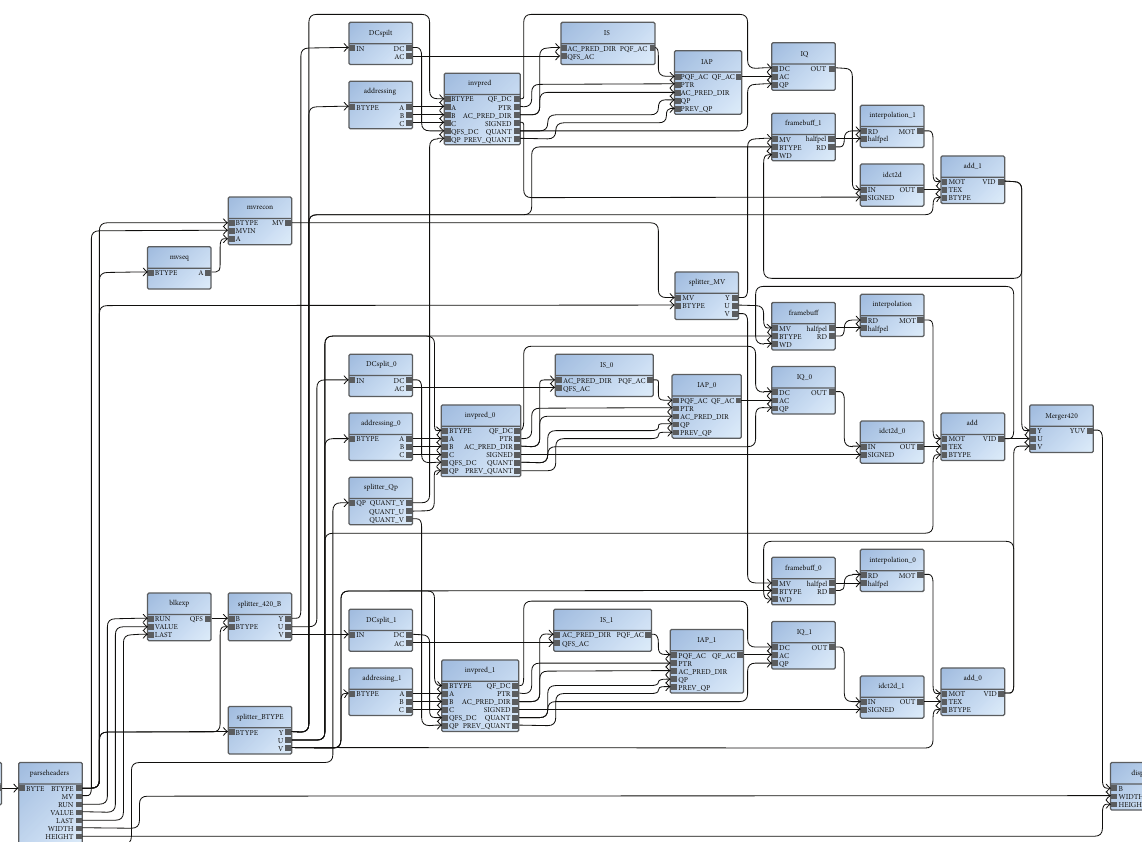
Figure 3: MPEG-4 SP decoder